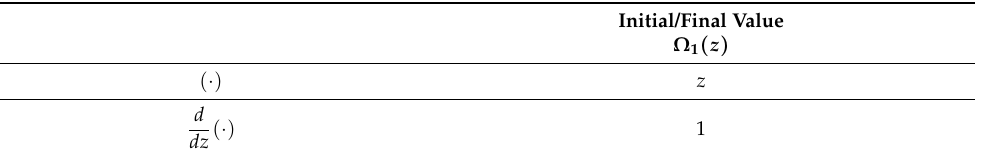
Table A2. Switching functions for a one constraint constrained expression, with the constraint of f (cid:48) , defined on domain of z ∈ [ z 0 , z f ]